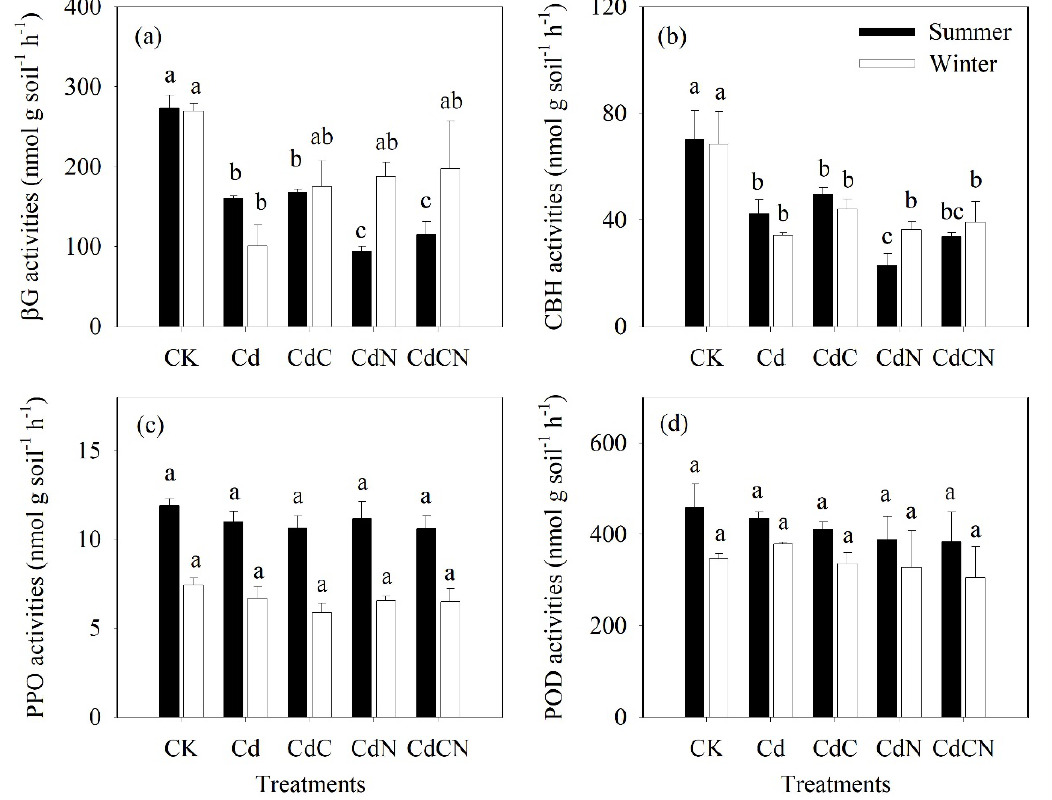
Figure 3. Potential activities for the C-degrading enzymes β G ( a ), CBH ( b ), PPO ( c ), and POD ( d ) as affected by five treatments in summer and in winter. βG, β -glucosidase; CBH, cellobiohydrolase; PPO, phenol oxidase; POD, peroxidase. The five treatments individually referred as CK (the control; with ambient Cd, ambient CO 2 , and ambient N deposition); Cd (with Cd addition, ambient CO 2 , and ambient N deposition); CdC (with Cd addition, elevated CO 2 , and ambient N deposition); CdN (with Cd addition, N addition, and ambient CO 2 ); and CdCN (with Cd addition, elevated CO 2 , and N addition). Within the same season and for each enzyme, means with different letters are significantly different ( p < 0.05) based on a one-way ANOVA followed by an LSD test.